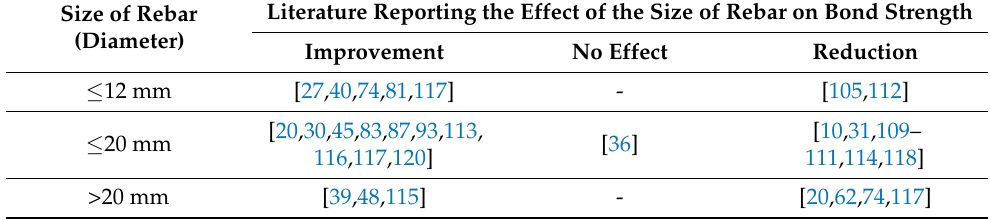
Table 6. Effect of rebar size on bond